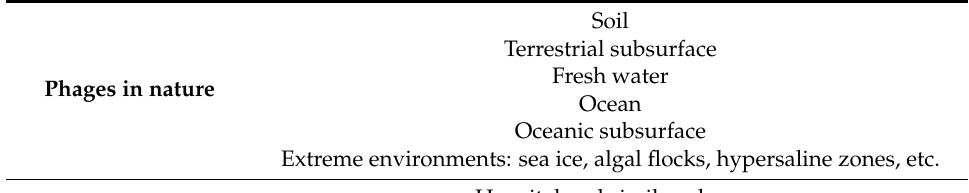
Table 1. Summary of the main places where phages can be found: nature, urbanized places, and the human